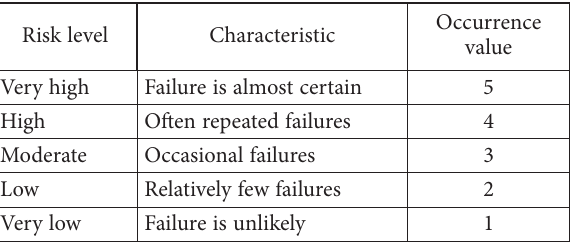
Table 2. Likert scale for the evaluation of occurrence